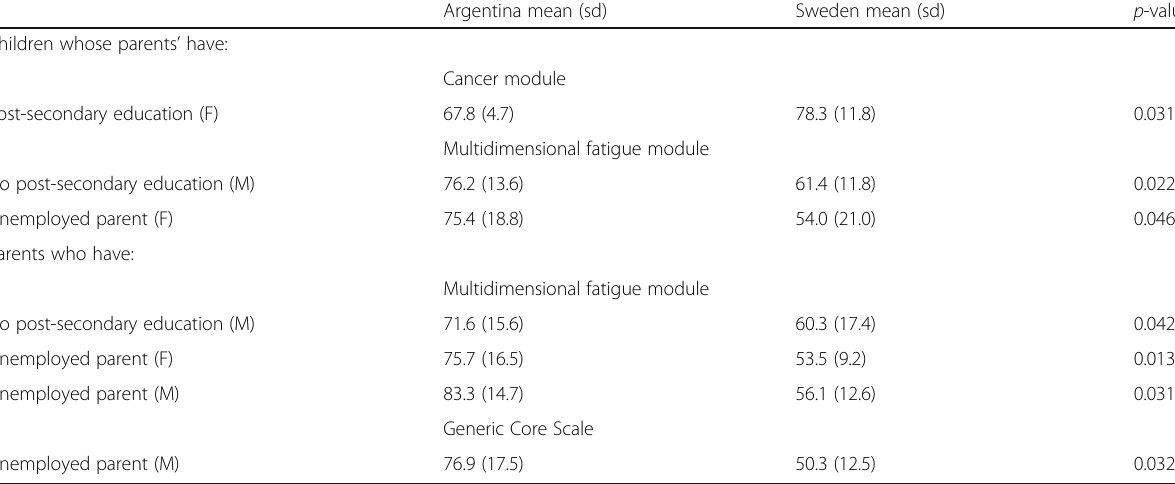
Table 6 Comparison of parents ’ education/work tasks and HRQOL in Argentina and Sweden